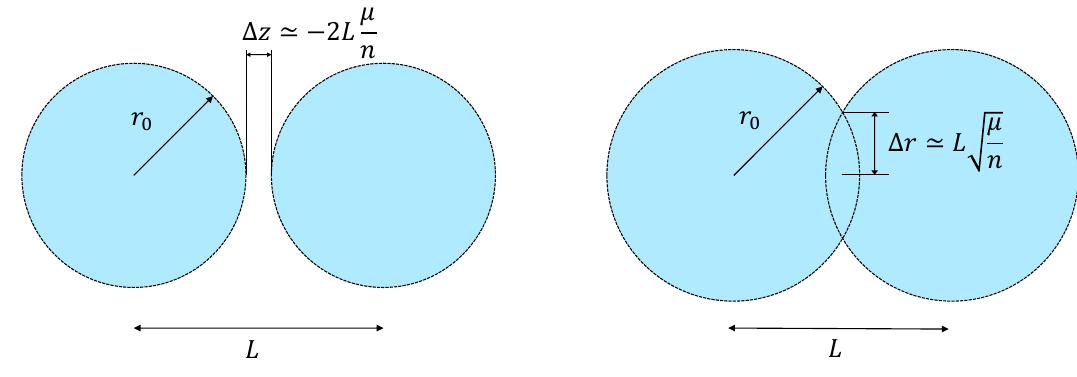
Figure 4 . The Newtonian potential for a double point source gives the parameters of the KR conifold solution, both in split ( (cid:22) < 0, left) and in fused ( (cid:22) > 0, right)